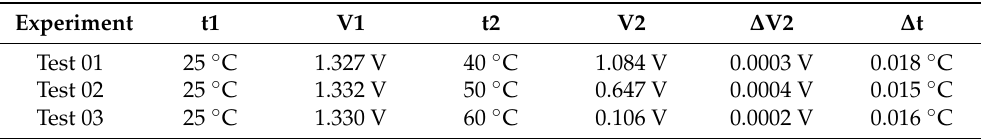
Table 1. Data recorded when evaluating the temperature stability of steam with the output of the photoelectric detector.